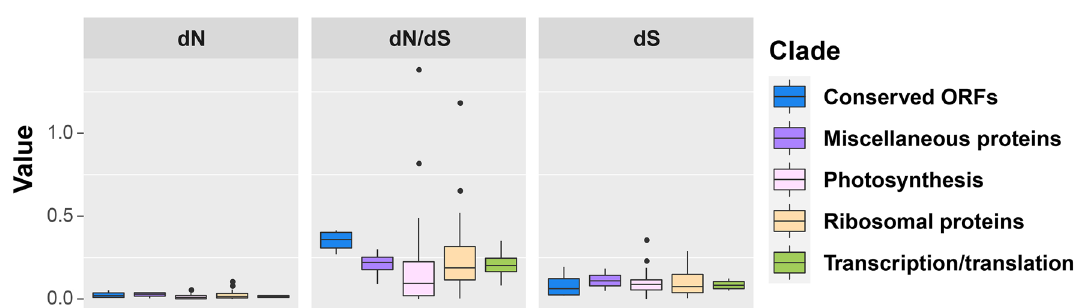
Figure 6. The mode and strength of selection of 75 chloroplast protein coding genes in Populus